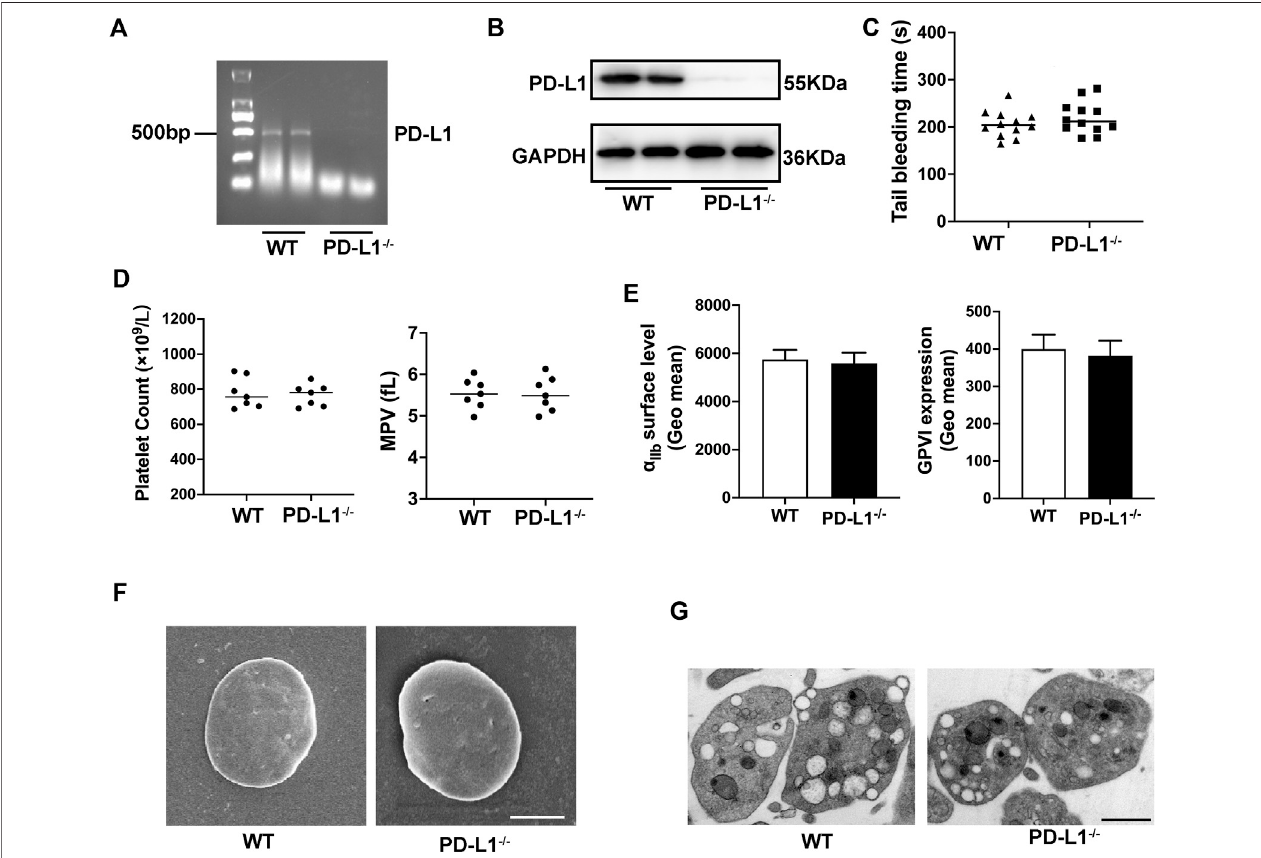
FIGURE1| PD-L1knockoutdoesnotaffectplateletcount,volume,morphology,andultrastructureunderhomeostasis. (A) PD-L1DNAexpressioninplateletfrom PD-L1 − / − mice; n = 5. (B) Representatives immunoblot of the PD-L1 protein in platelet from WT mice and PD-L1 − / − mice; n = 5. (C) Tail bleeding time measured after amputating 2 mm ofthe tail tip. Each dot represents1 individual mice. n =12. (D) Platelets count and mean platelets volume (MPV) weredetermined from PD-L1 − / − and WTmicebyanautomaticbloodanalyzer; n =7. (E) Theexpressionofplateletreceptors α IIb β 3andGPVIwasdetectedby fl owcytometry, n =7. (F) Representative scanning electron microscope images of platelets morphology from WT mice and PD-L1 − / − mice; Scale bar = 1 μ m; n = 5. (G) Representative transmission electron microscopy images of platelets ultrastructure from WT mice and PD-L1 − / − mice. Scale bar = 1 μ m; n = 5. Data are mean ±